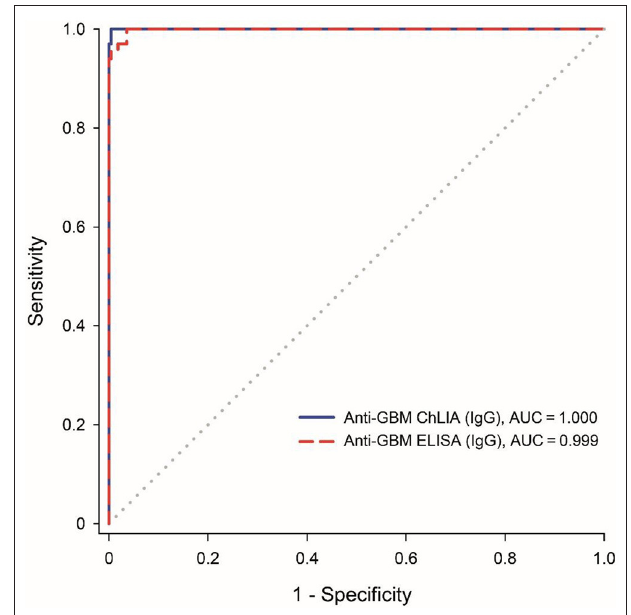
FIGURE 1 | Assay comparison using receiver operating characteristics (ROC) curve analysis for the discrimination between anti-GBM patients ( n = 67) and disease controls ( n = 221). The diagonal line indicates no discrimination (area under the curve: 0.5).